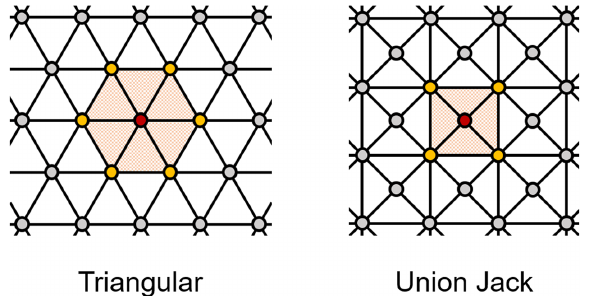
FIG. 3. Two-dimensional triangulated lattices. For each lat- tice, the shaded area is the unit cell we choose; the red vertex is the center vertex that only belongs to its cell; the yellow ver- tices are shared with neighboring cells. The Boolean functions are decomposed according to the